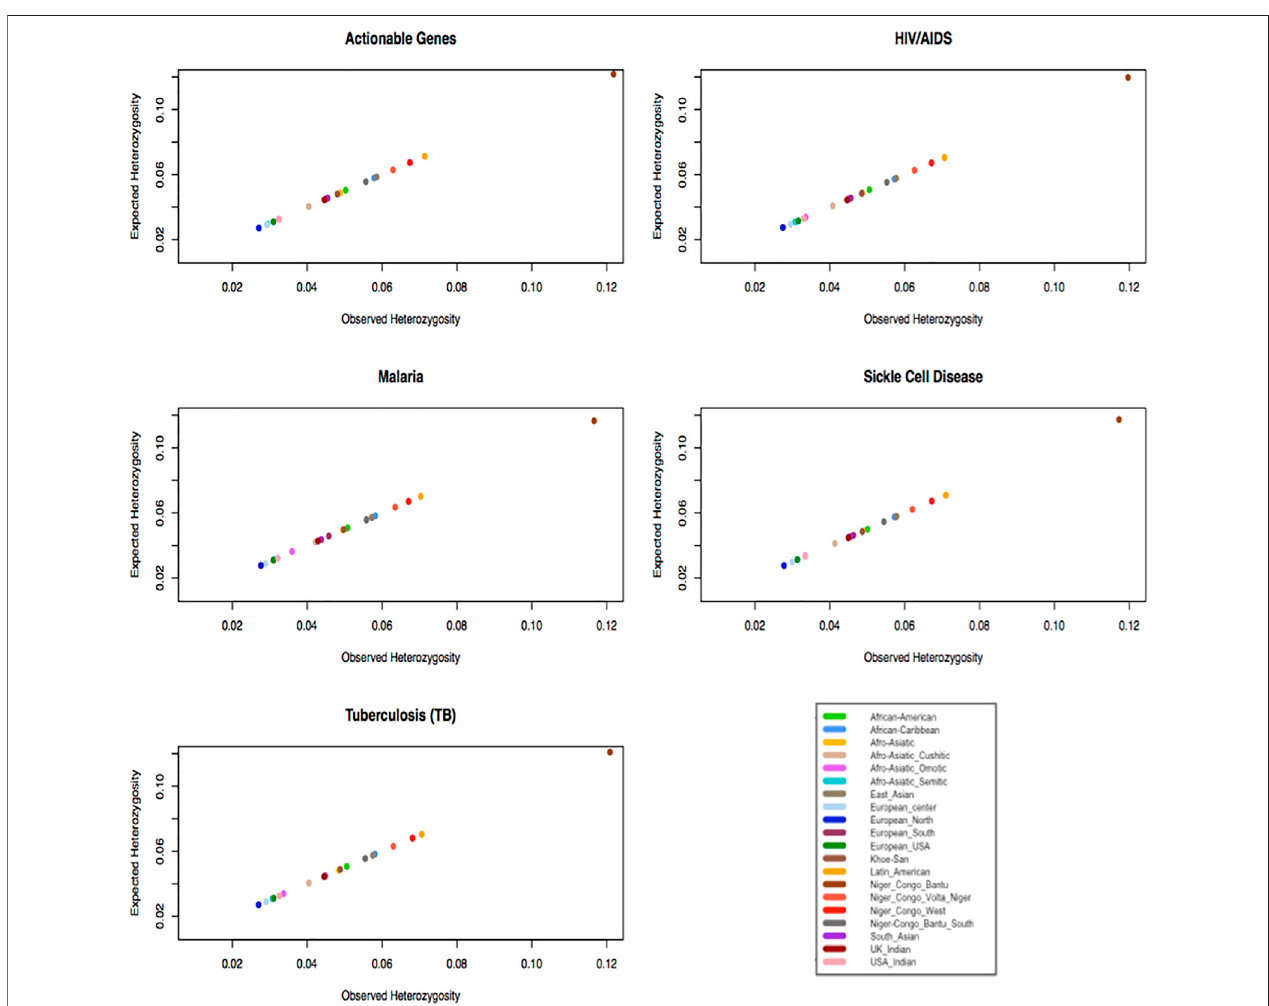
FIGURE 5 | Plot expected heterozygosity as a function of observed heterozygosity per gene of speci fi c diseases within ethnolinguistic cultural groups.